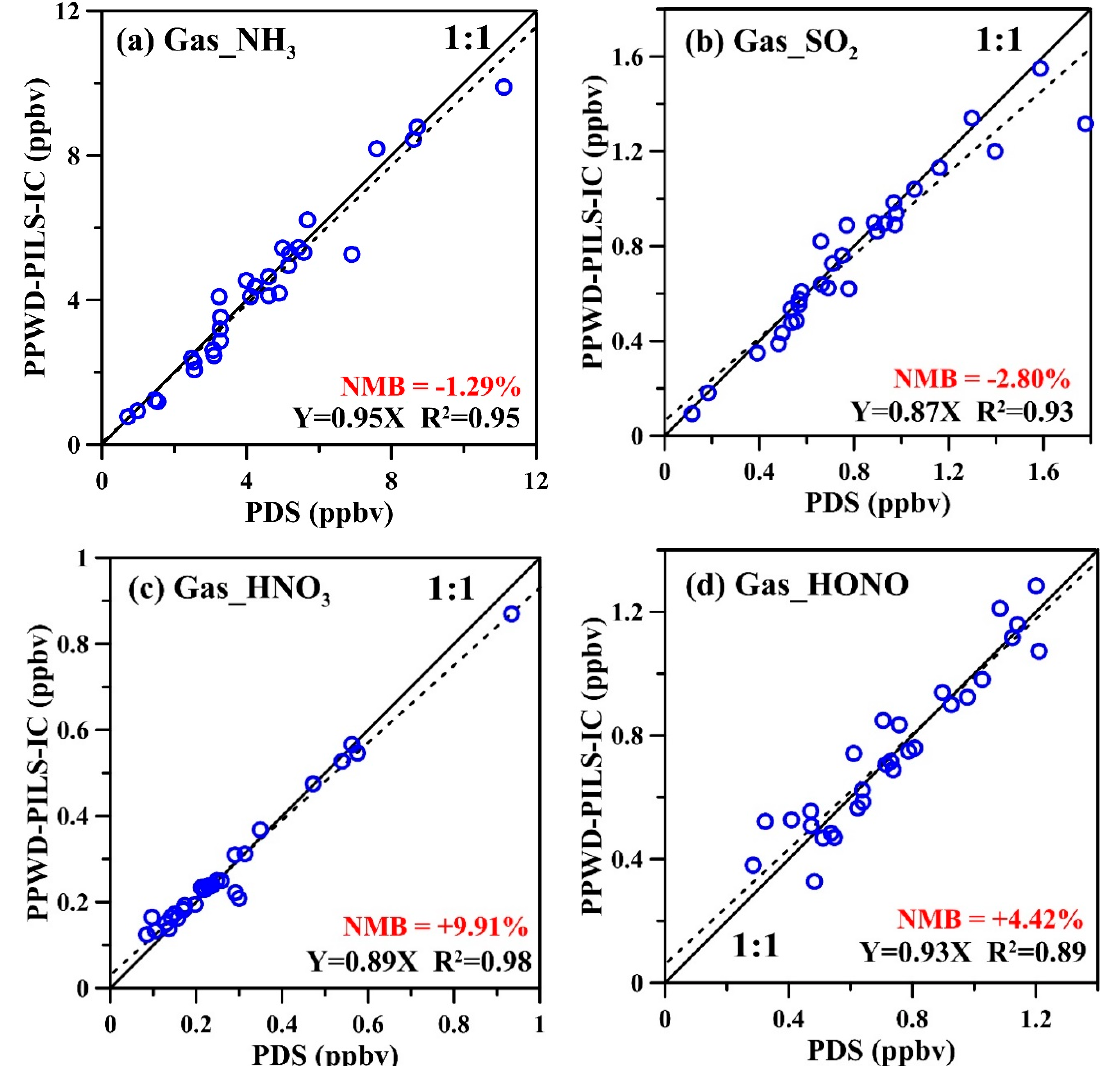
Figure 5. Correlation plot of the PPWD-PILS-IC and the PDS for the precursor gases. ( a ) NH 3 ; ( b ) SO 2 ; ( c ) HNO 3 ; and ( d ) HONO.